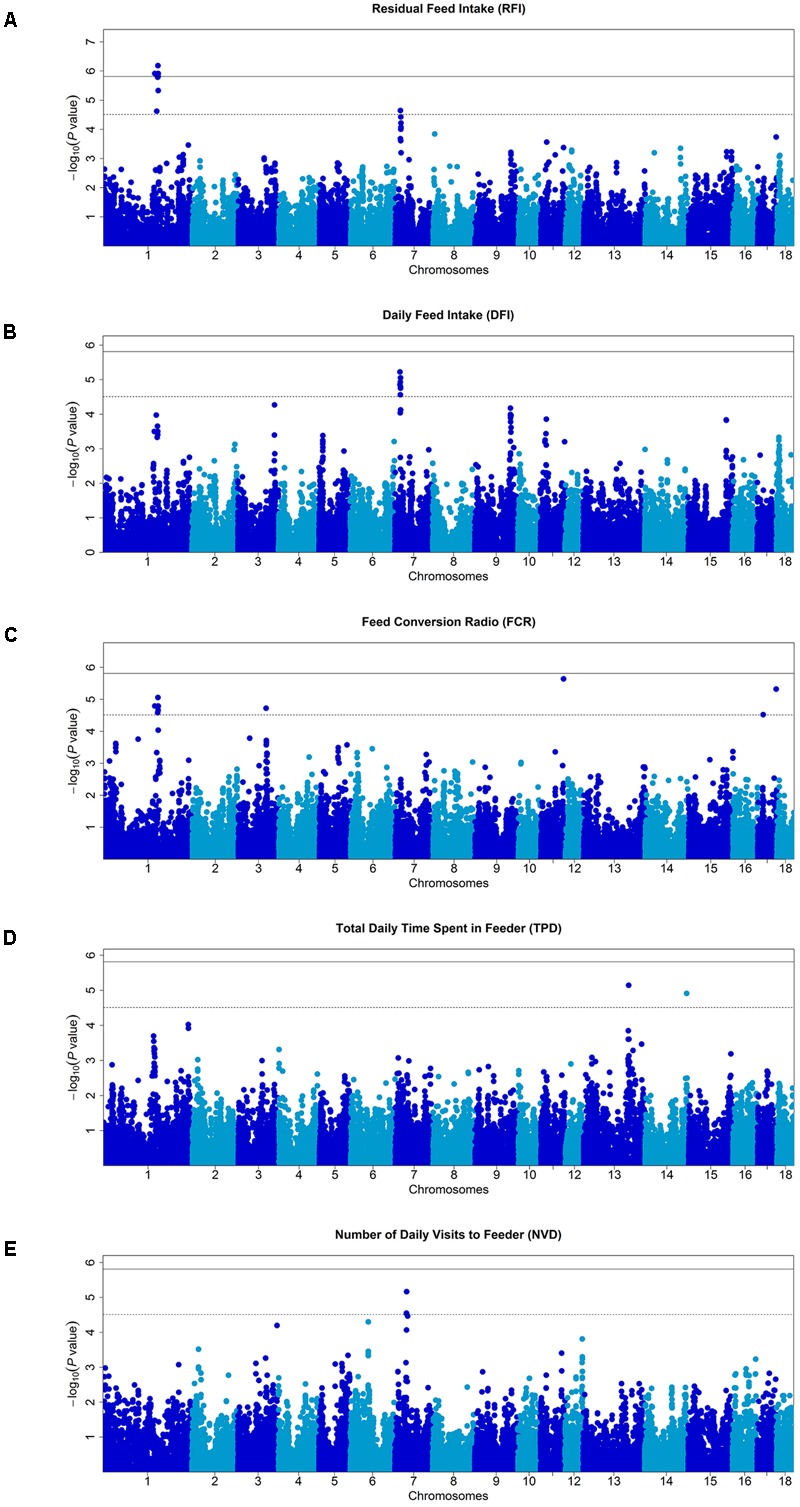
Manhattan plots of genome-wide association studies for feeding behavior and feed efficiency in male Duroc pigs. In the Manhattan plots, negative log10 P-values of the quantified SNPs were plotted against their genomic positions. Different colors indicate various chromosomes. The solid and dashed lines indicate the 5% genome-wide and chromosome-wide Bonferroni-corrected thresholds, respectively. On the vertical axis, Manhattan plot for (A) residual feed intake (RFI), (B) total daily feed intake (DFI), (C) feed conversion ratio (FCR), (D) total daily time spent in feeder (TBD), and (E) number of visits to feeder (NVD), respectively.